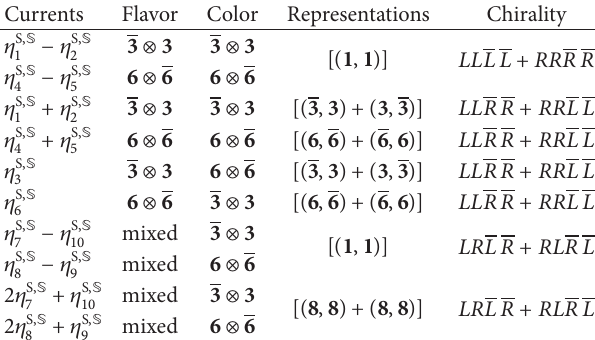
Table 1: Flavor singlet tetraquark currents of 𝐽 𝑃 = 0 + , showing their chiral representations and chirality. The second and third columns show the flavor and color structures of the diquark and antidiquark inside,